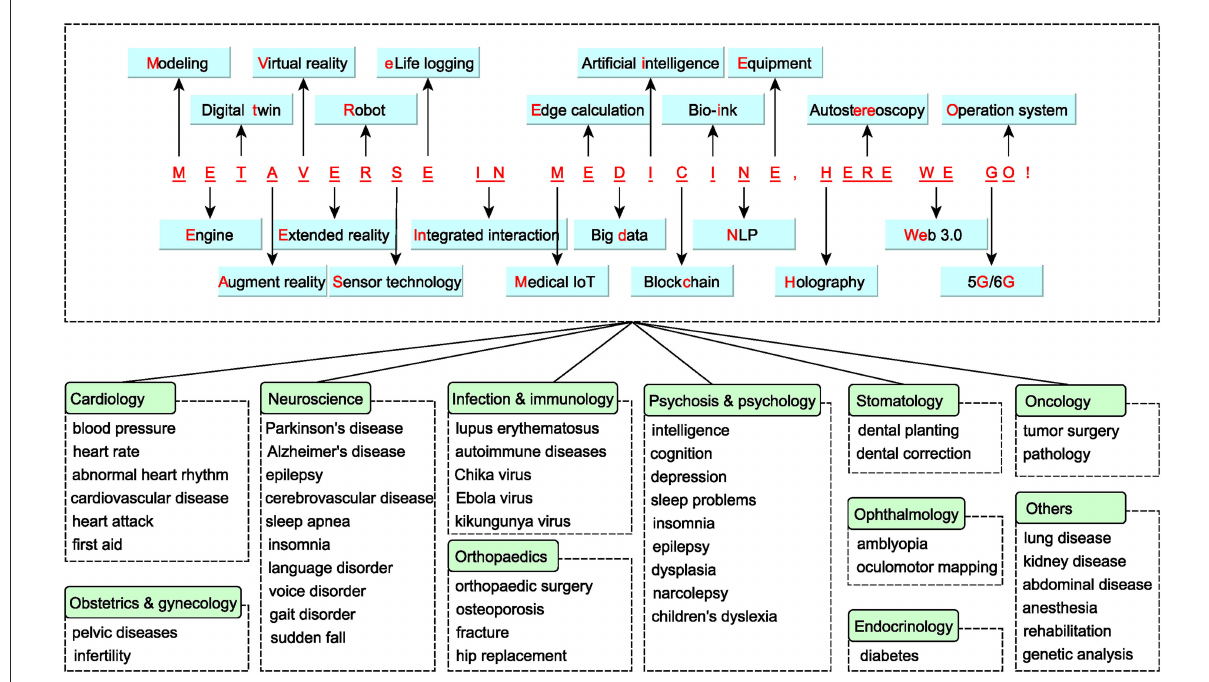
visual intelligent hospital for full-time intelligent operation and maintenance. All the resources in the metaverse of medicine can be shared. Medical treatment, cloud